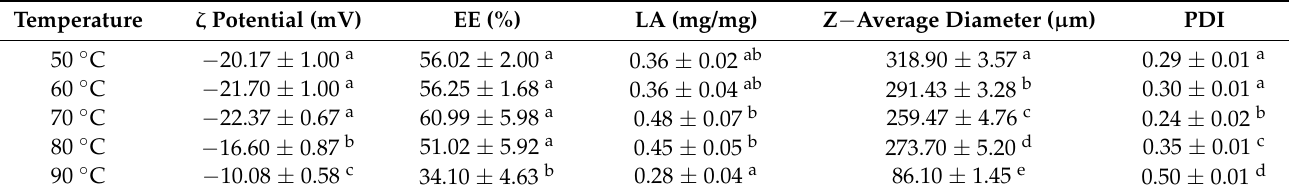
Table 2. Characteristics of the microcapsule under different emulsifying